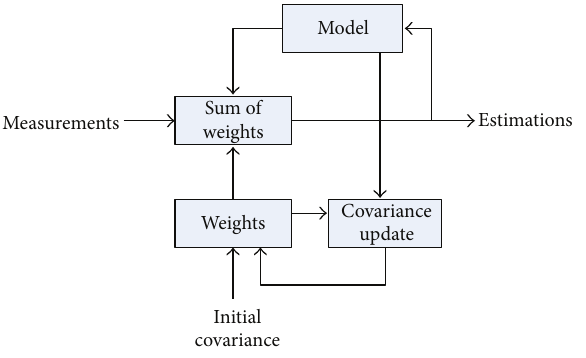
Figure 1: The Kalman filter algorithm flowchart.